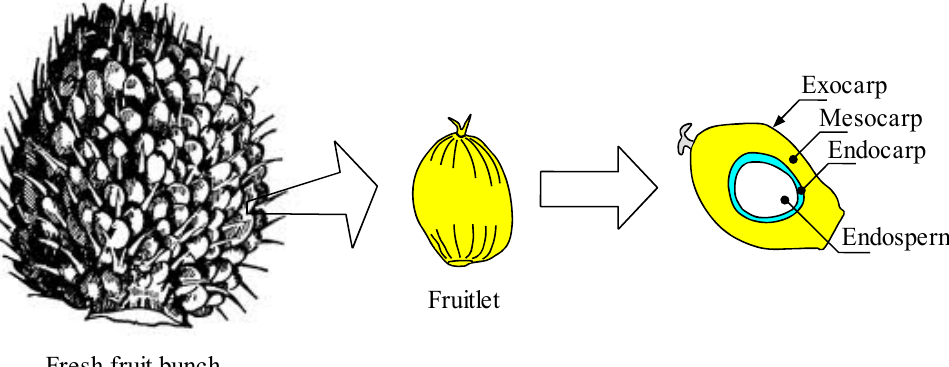
Figure 2. Ladder stages of the Oil Palm Fresh Fruit Bunch (FFB).